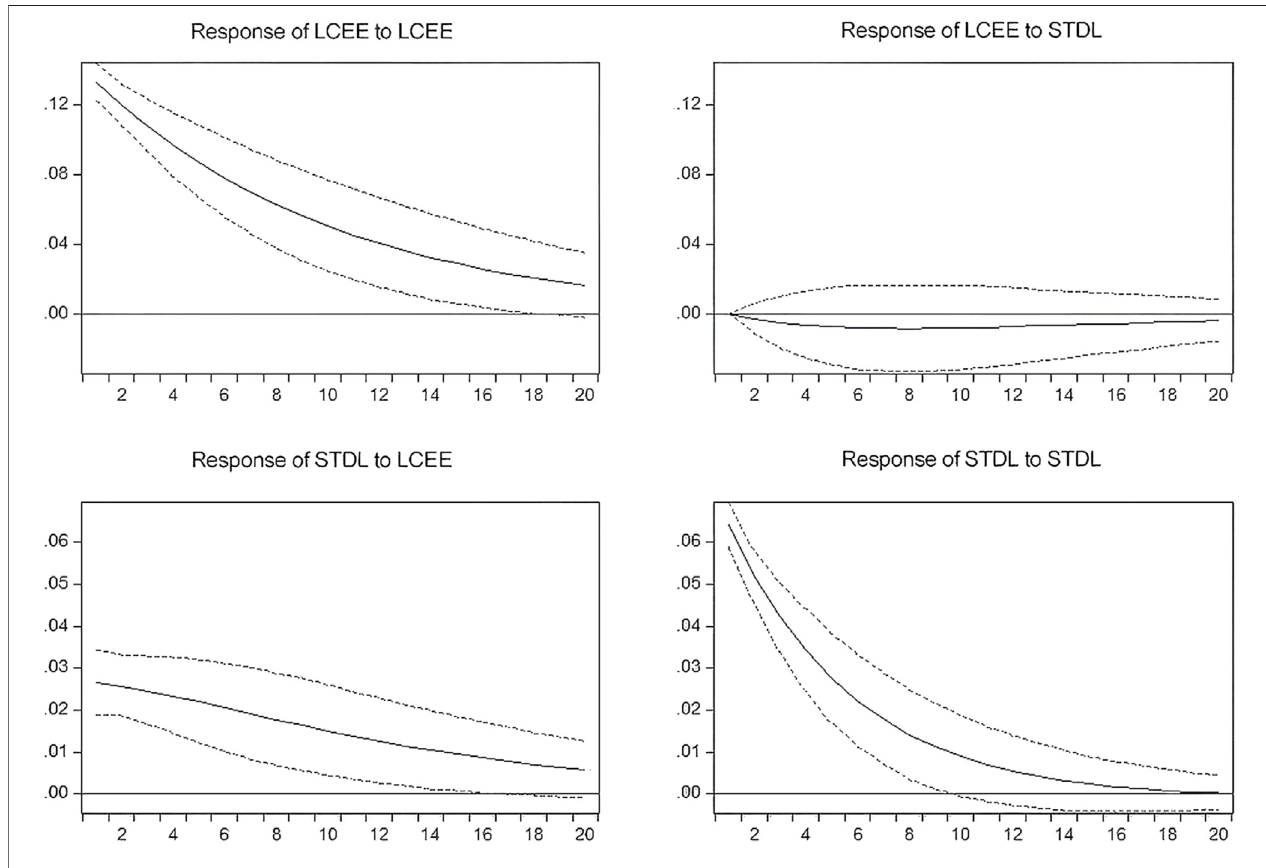
FIGURE 6 | Impulse response analysis results.